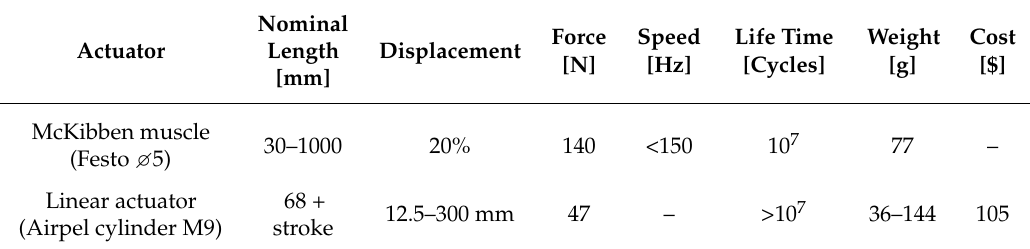
Table 3. Comparison of conventional pneumatic